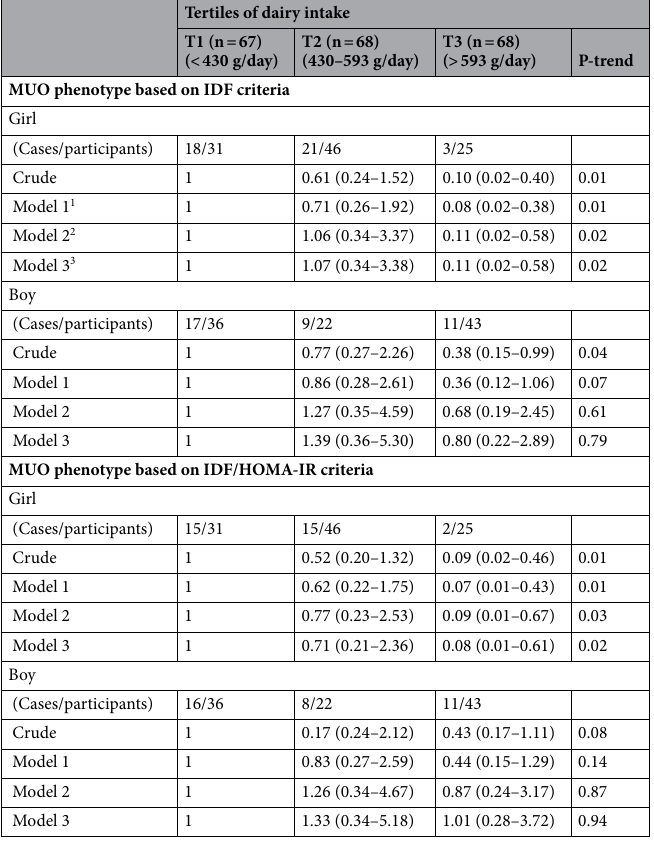
Table 4. Multivariate adjusted odds ratio (OR) and 95% confidence interval (CI) for MUO across energy- adjusted tertiles of dairy intake, stratified by sex. All values are odds ratios and 95% confidence intervals. 1 Model 1: Adjusted for age, sex, total energy intake, and fat intake (percent of energy). 2 Model 2: Additionally adjusted for physical activity and socioeconomic status (parental education, parental job, number of family members, having car in the family, having computer/laptop, having personal room and having trip). 3 Model 3: Additionally adjusted for body mass index (BMI).